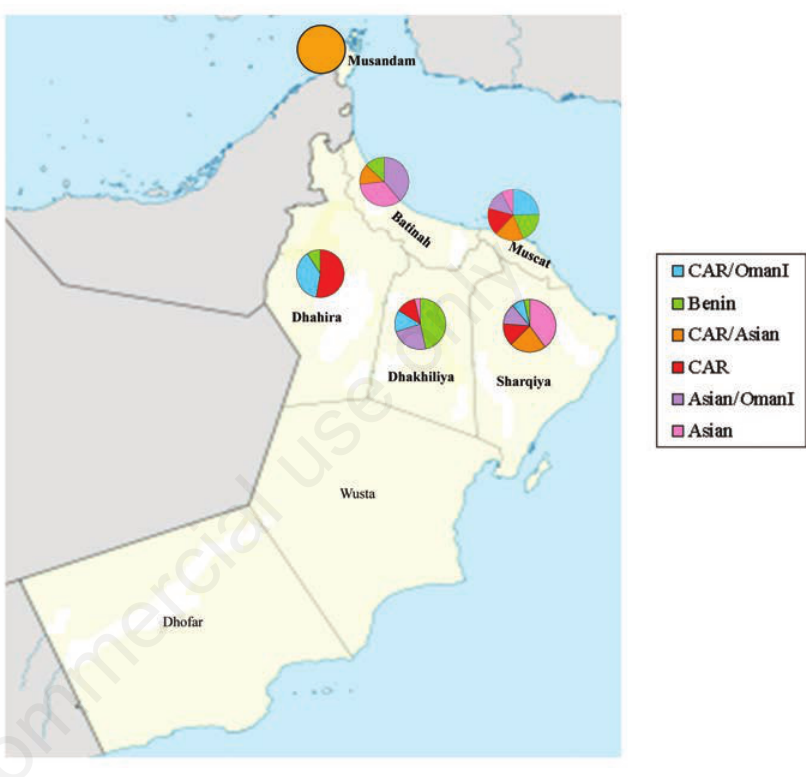
Figure 2. The geographical distribution of the β globin gene cluster haplotypes within